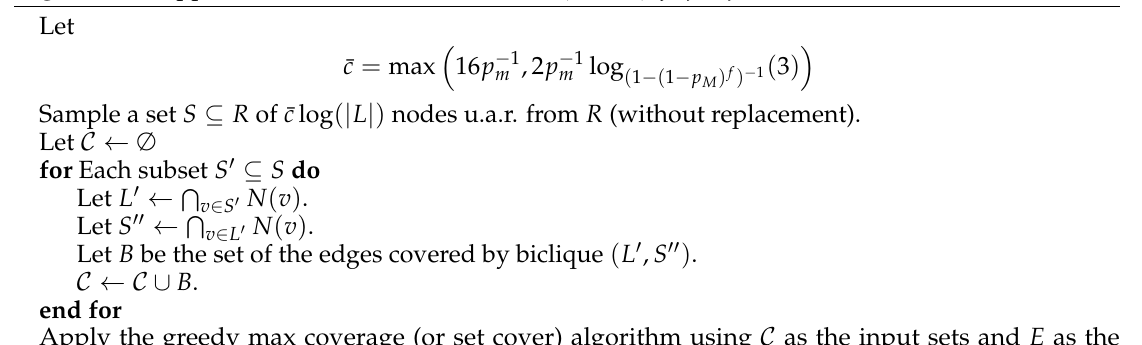
Algorithm 3 ApproxCoverOneSideRandom( G = ( L , R , E ) , f , p m , p M , k